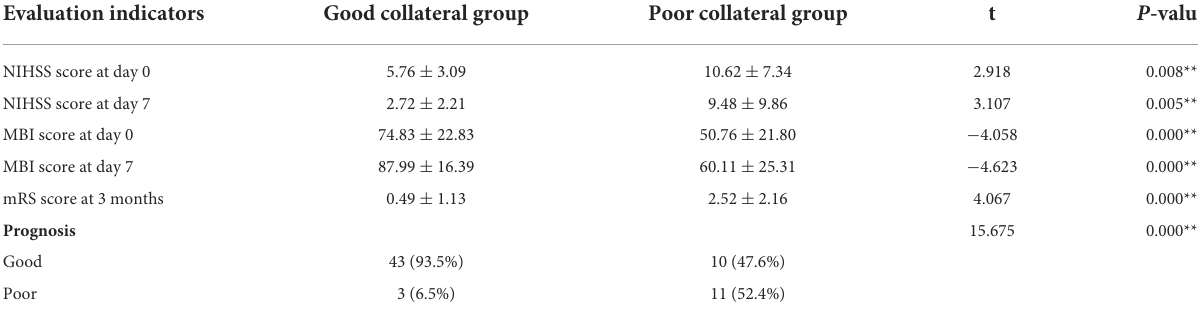
TABLE 3 Clinical outcome of the included